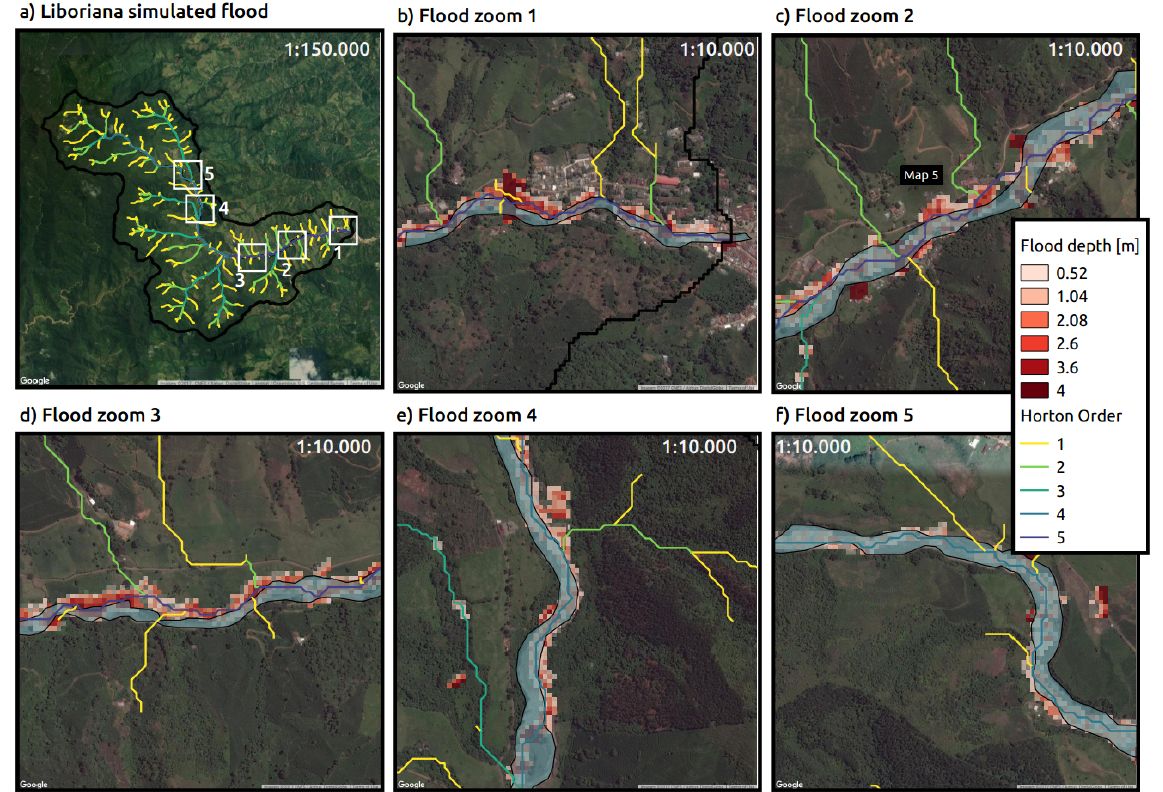
Figure 16. Simulated flood spot at the peak of Event 2 in different locations (image courtesy of CNES/Airbus via © Google Earth). (a) Basin drainage network. White squares correspond to regions of interest highlighted in (b) – (f) . The colors of the streams correspond to the Strahler order of the network. (b) Zoom at the outlet of the basin, where an important portion of the human and infrastructure losses took place. (c) Zoom at La Margarita settlement also affected by the flash flood. (d–f) Zoom at key locations along the principal stream. Observed flood spots are shown in blue polygons and model flood spots in red to white